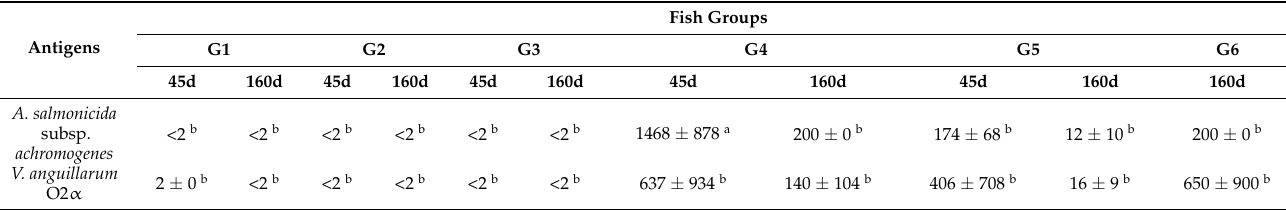
Table 3. Results of the agglutination assay using the serum of turbot injected with PBS, eolane, montanide, autogenous (one dose), and commercial vaccines (one and two